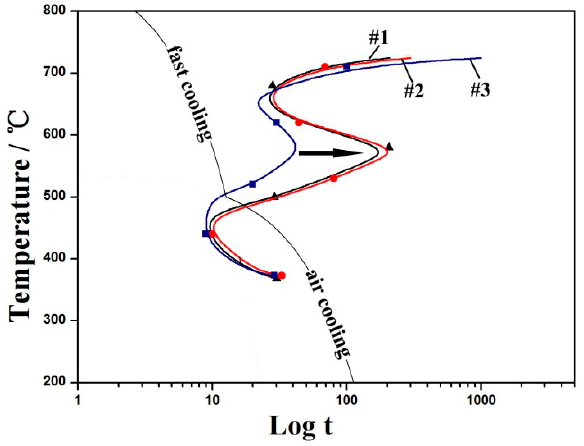
Figure 6. Calculated TTT diagrams for the Mo-free steel (#1) and the Mo-containing steels (#2 and #3).